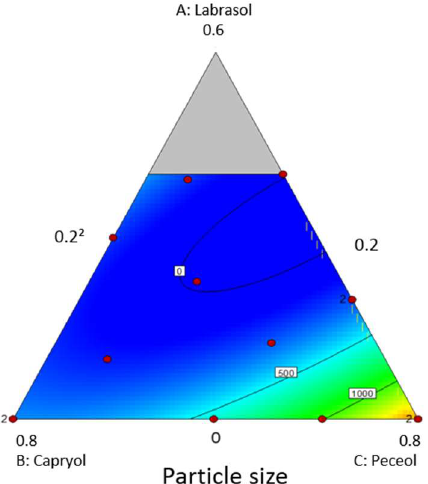
Figure 1. Pseudo-ternary phase diagram of SNEDDS. In the white rectangles is indicated the particle size of each corresponding composition. The blue areas indicate a lower particle size, while yellow and red areas indicate larger sizes.